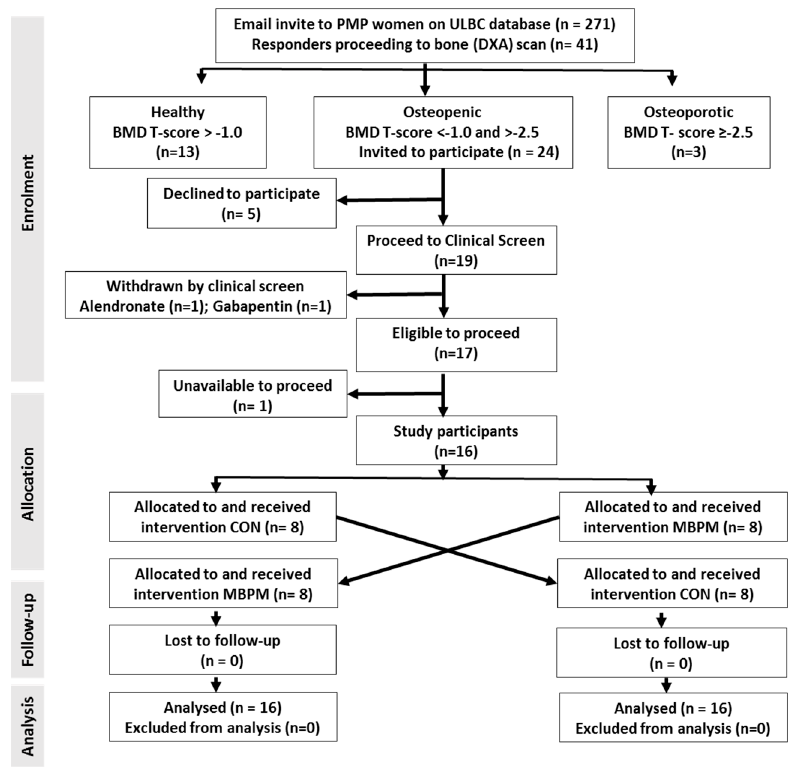
Figure 1. Flow diagram of participant enrolment, allocation, follow-up, and analysis.